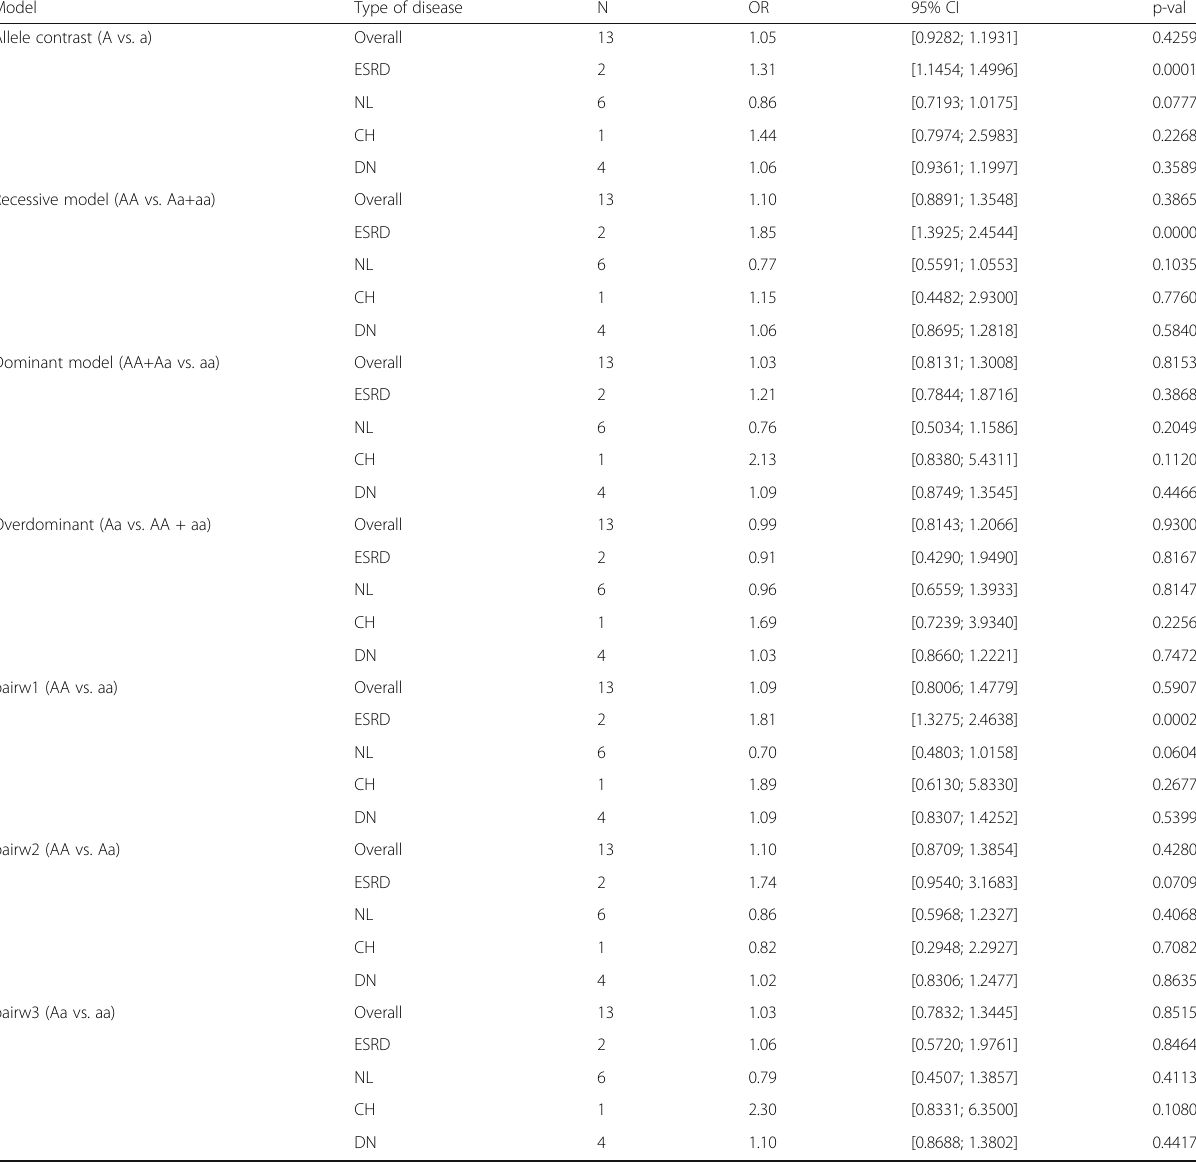
Table 4 Subgroup analysis showing disease-specific risk with VDR ApaI polymorphism Model Type of disease N